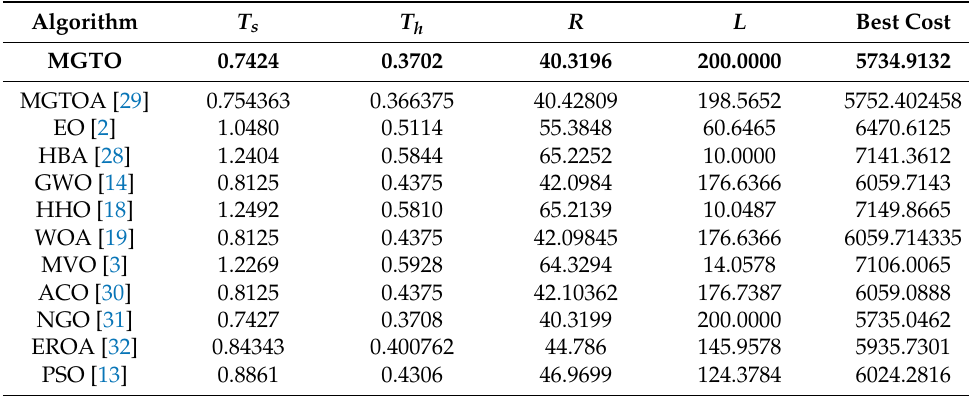
Table 9. Experimental results of the pressure vessel design problem test.